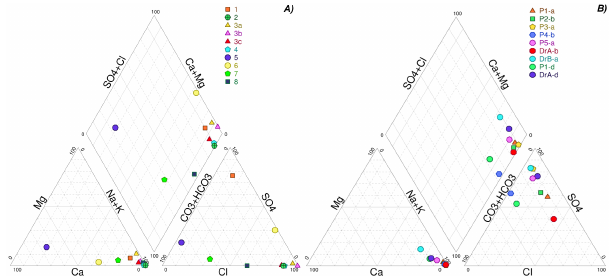
Fig. 5. Piper diagram. (a) Water sample DrA compared with com- mon shallow groundwater (point: 5), other springs (point: 6 – Cervi, 2003; 7 – Venturelli et al., 2003), mud volcanoes (point: 3a, c – Mar- tinelli et al., 1989), baths (point: 2, 4 – Boschetti et al., 2010) and hydrocarbon seep (point: 8) as described in Fig. 1a. (b) Ca’ Lita water samples from the B and D